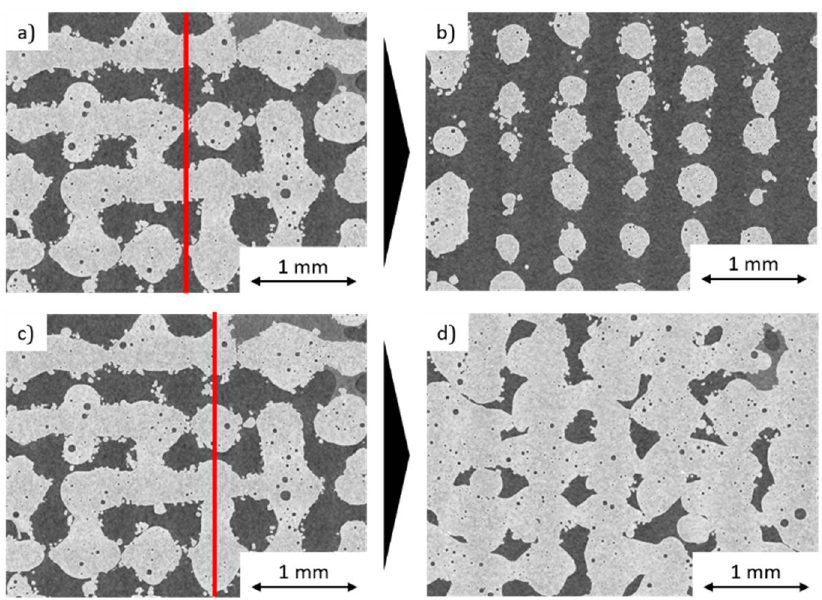
Figure 7. CT-Image: ( a ) top view, ( b ) sectional side view, ( c ) top view, ( d ) sectional side view of a lattice-structure (P L = 385 W, v s = 500 mm/s, g w = 0.3 mm, l s = 250 µm).